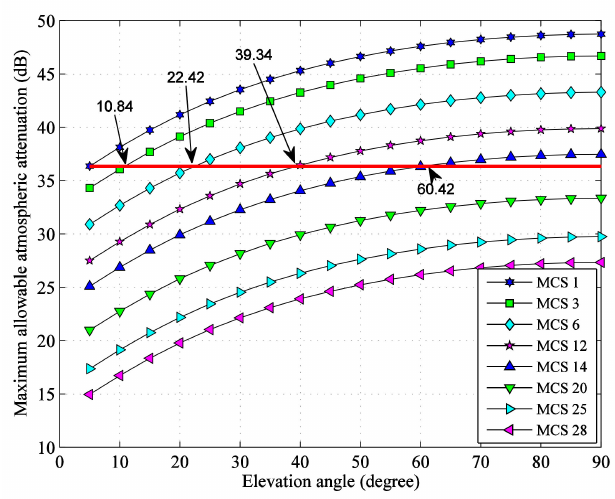
Figure 6. Switching elevation angle of adjacent MCS (initial minimum MCS 1).